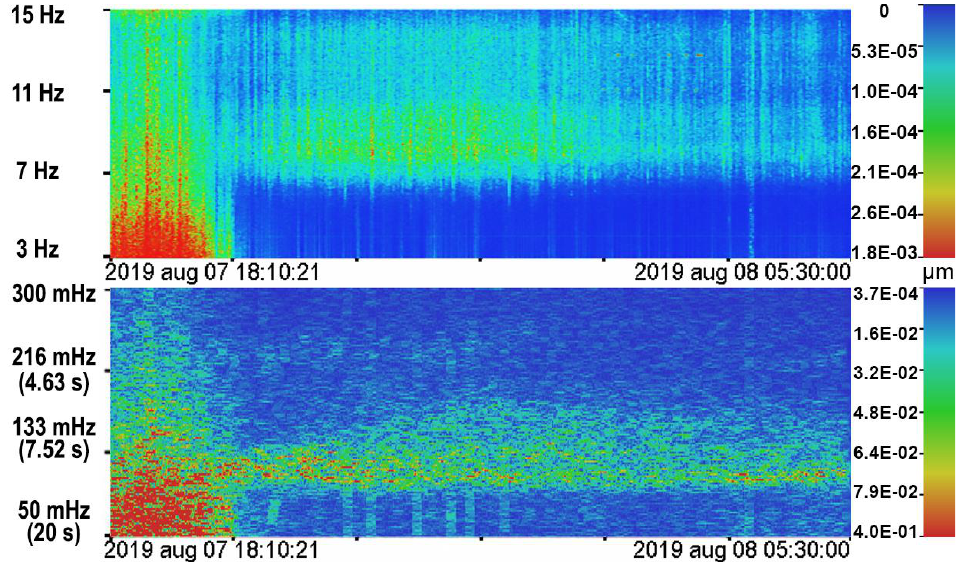
Figure 13. Dynamic spectrograms of laser strainmeter data during influence of Francisco typhoon.